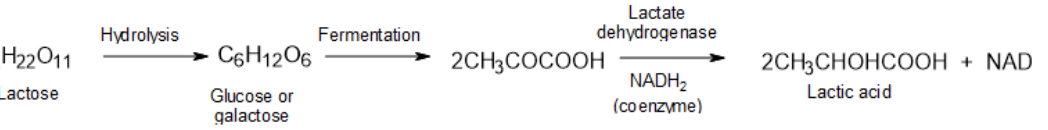
Figure 3. Scheme presenting receiving lactic acid [5].